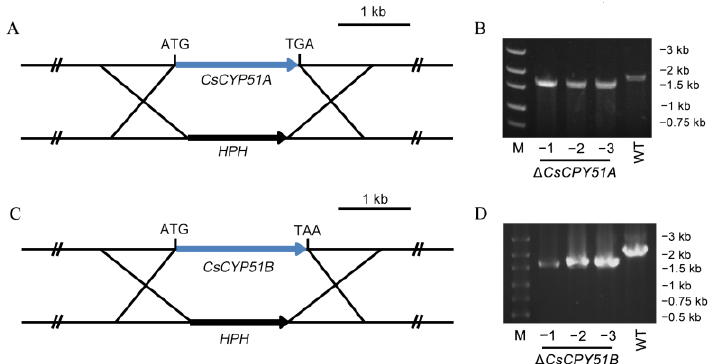
Colletotrichum boninense was used as an outgroup. The scale bar shows 0.07 expected changes per site.